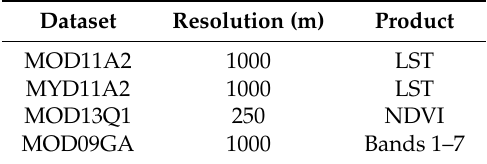
Table 2. Summary of MODIS image products used in this study.